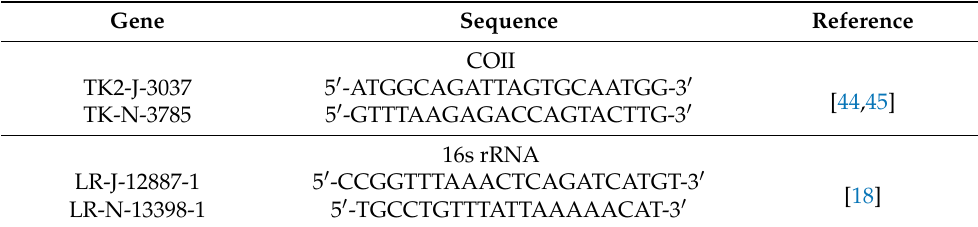
Table 2. Primers used in the analysis of genetic